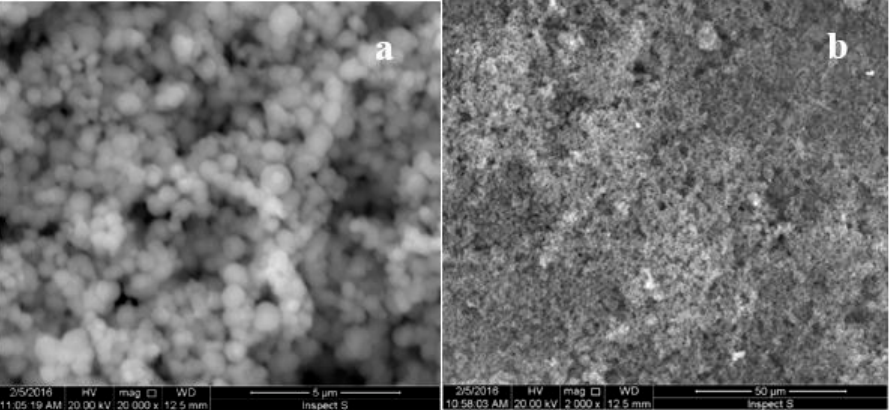
Figure 1. SEM images of the gold electrode surface modified with the polypyrrole-MCM-48 composite, at ( a ) 20000× magnification and ( b ) 2000× magnification.